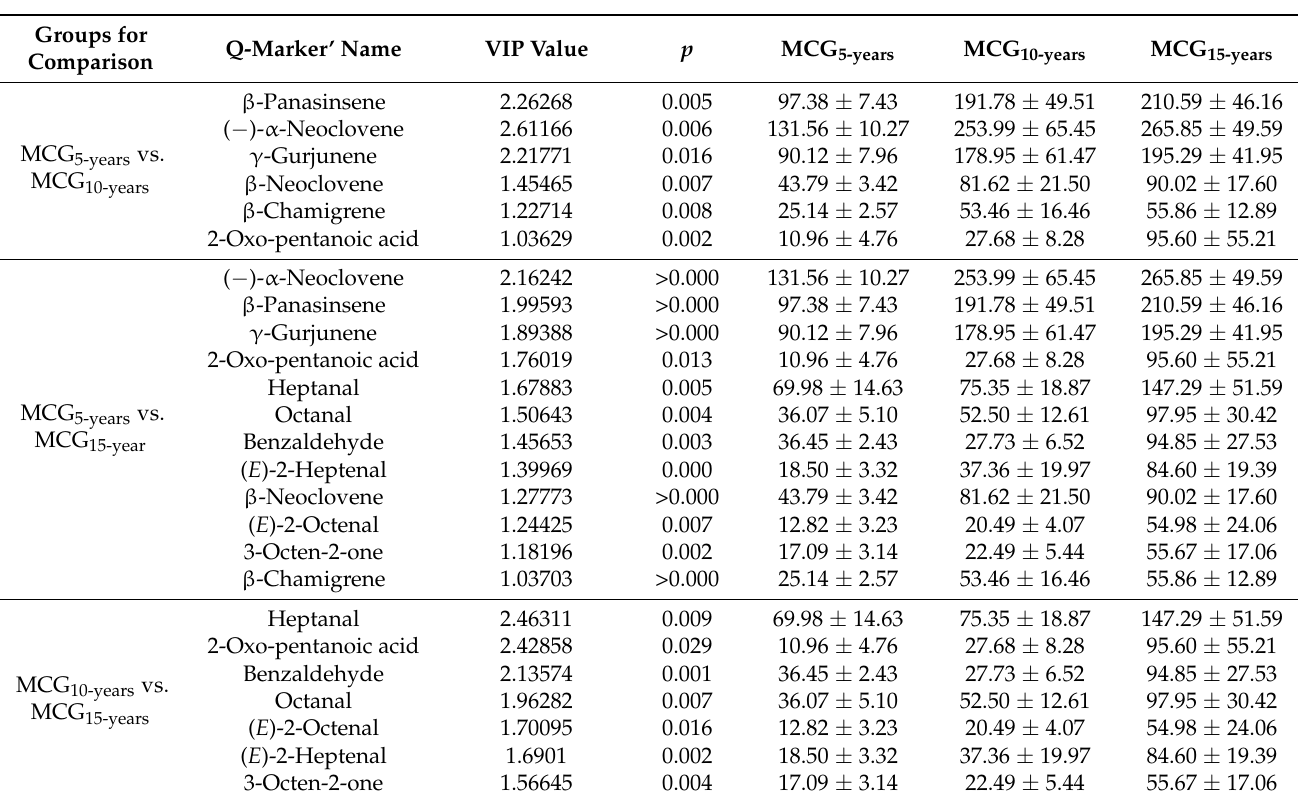
Table 3. The detailed information of the five potential chemo-markers among MCG with 5-,10-,15- growth